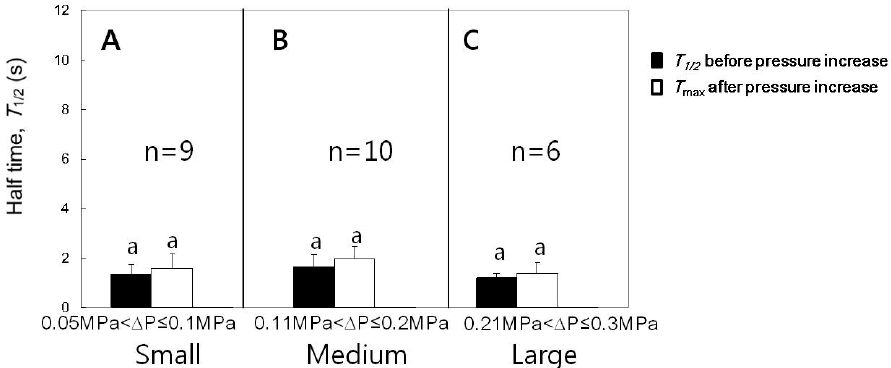
Figure 4. Effects of the increased cell turgor pressure on the maximum T of approximately 1 s. ( A – C ) The increases of the turgor by the increments in small, medium, or large ranges did not increase T . Mean values ± SD were plotted. The significance in differences was tested and noted with different alphabets (n = 6–10 cells, paired t -tests for each range of turgor pressure increase, p < 0.05).